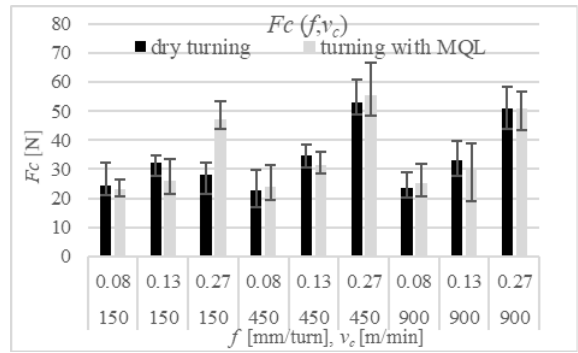
Figure 16. Noise and disturbance values in composite turning with diamond coated carbide insert (1810), obta– ined through filtration with wavelet Daubechies 4 (db4).